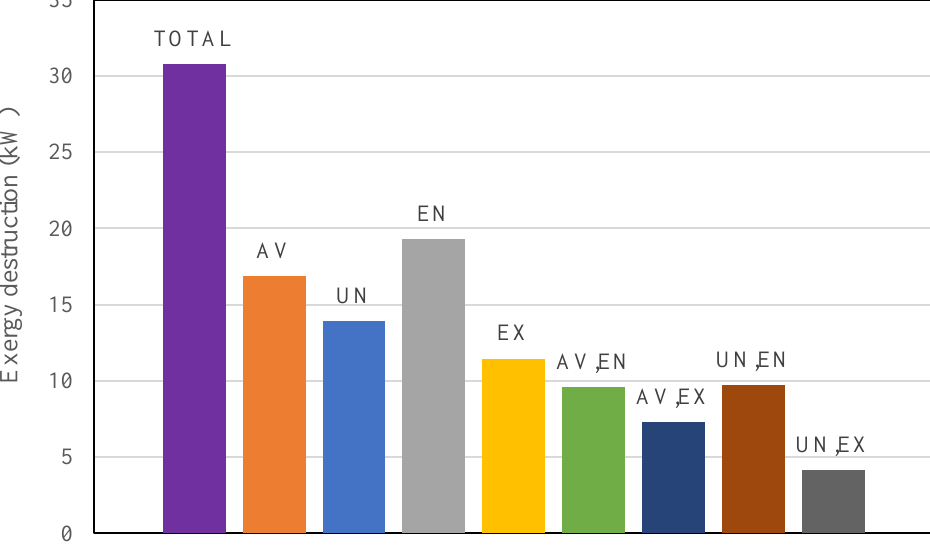
Figure 7. Total exergy destruction rate for the different parts in BORC.